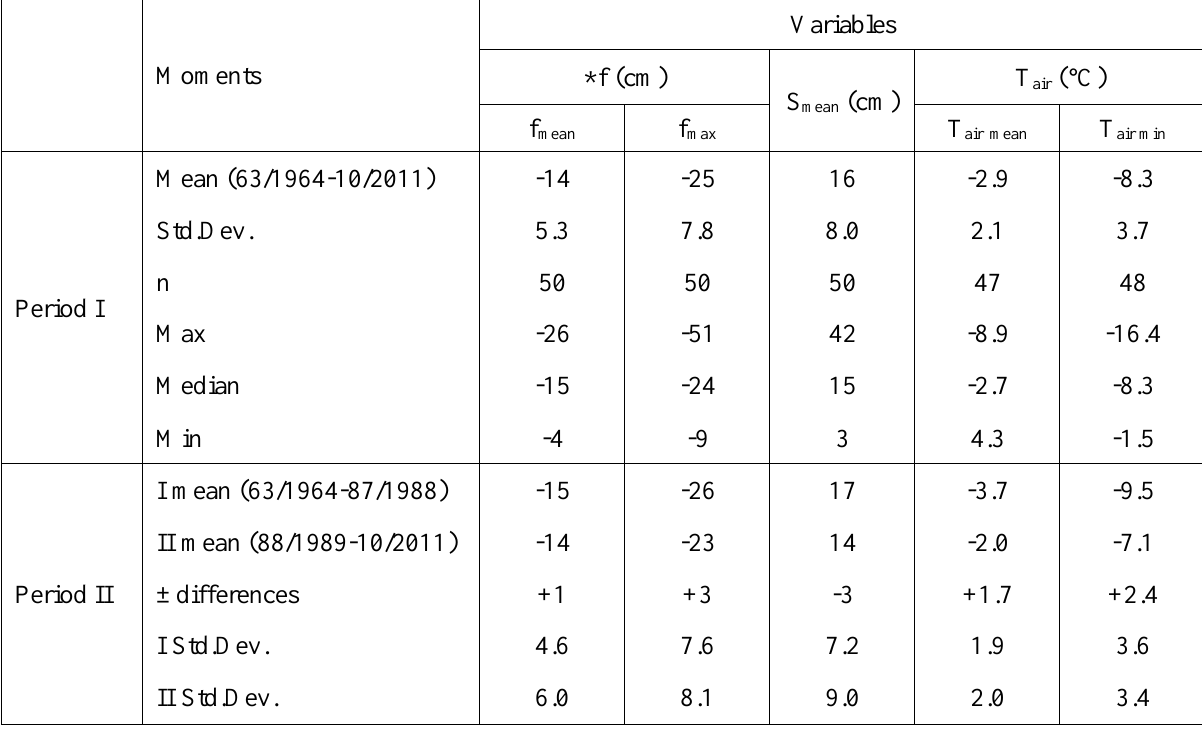
and f , respectively), snow mean max ) for average winter seasons air min